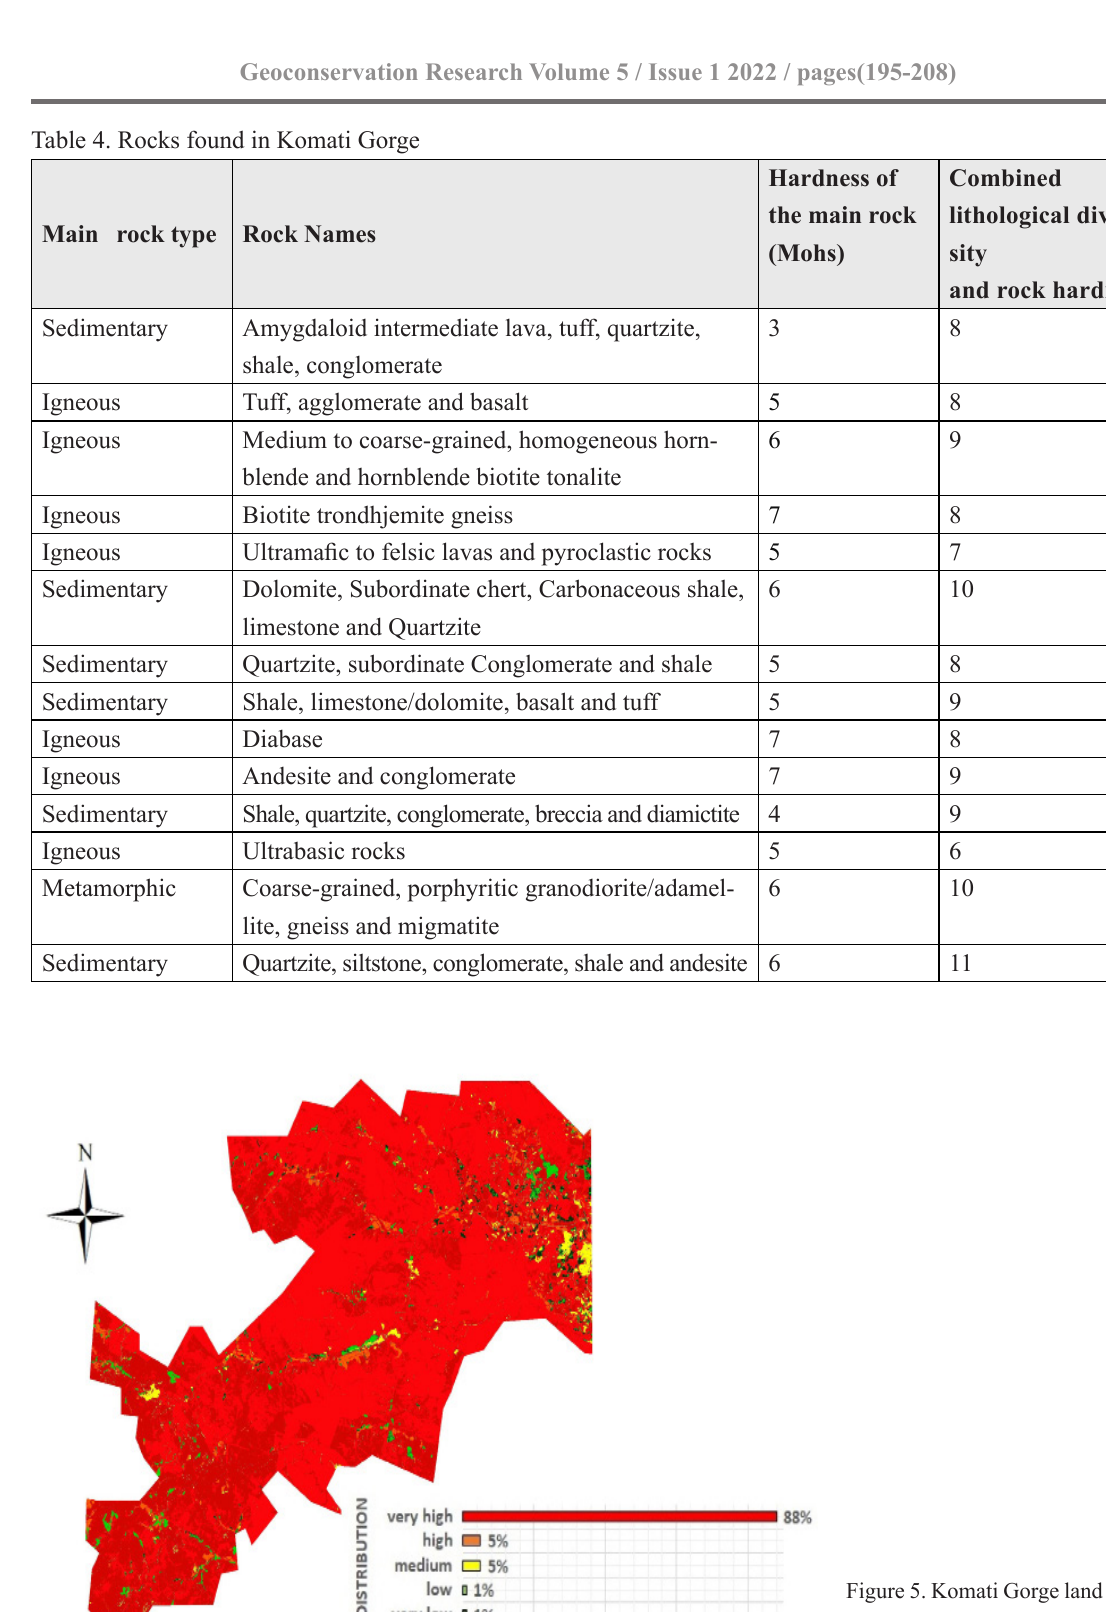
Figure 5. Komati Gorge land use/ land cover factor